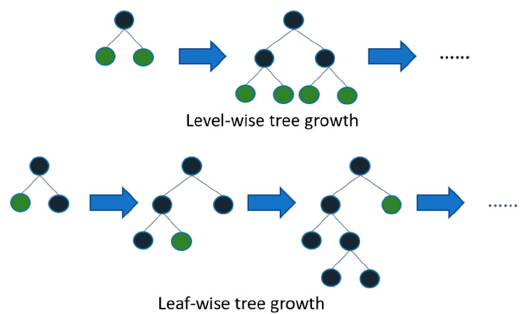
Figure 2. Illustration of level-wise and leaf-wise tree growth approaches for gradient-boosted decision trees.